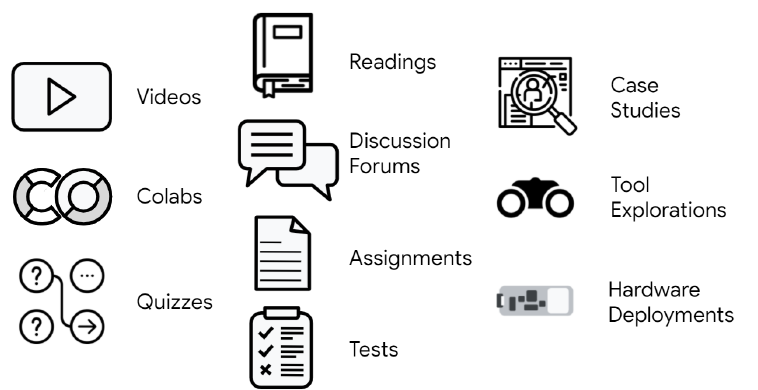
Figure 9. Learner activities. We employ a wide array of learning activities to give students an immersive, self-paced online